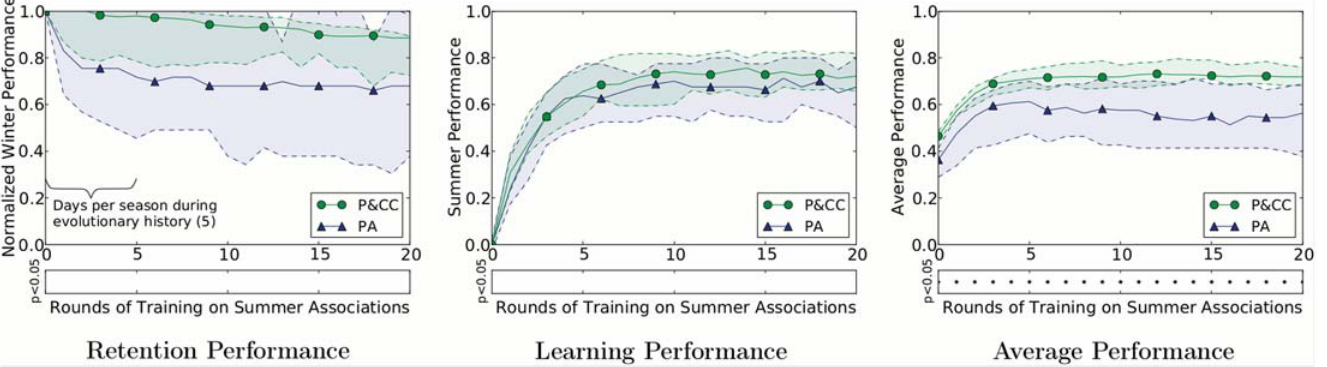
Fig 8. Comparing the retention and forgetting of networks from the two treatments. P&CC networks, which are more modular, are better at retaining associations learned on a previous task (winter associations) while learning a new task (summer associations), better at learning new (summer) associations, and significantly better when measuring performance on both the associations for the original task (winter) and the new task (summer). Note that networks were evolved with five days per season, so the results during those first five days are the most informative regarding the evolutionary mitigation of catastrophic forgetting: we show additional days to reveal longer-term consequences of the evolved architectures. Solid lines show median performance and shaded areas indicate 95% bootstrapped confidence intervals of the median. The retention scores (left panel) are normalized relative to the original performance before training on the new task (an unnormalized version is provided as Supp. S6 Fig). During all performance measurements, learning was disabled to prevent such measurements from changing an individual ’ s known associations